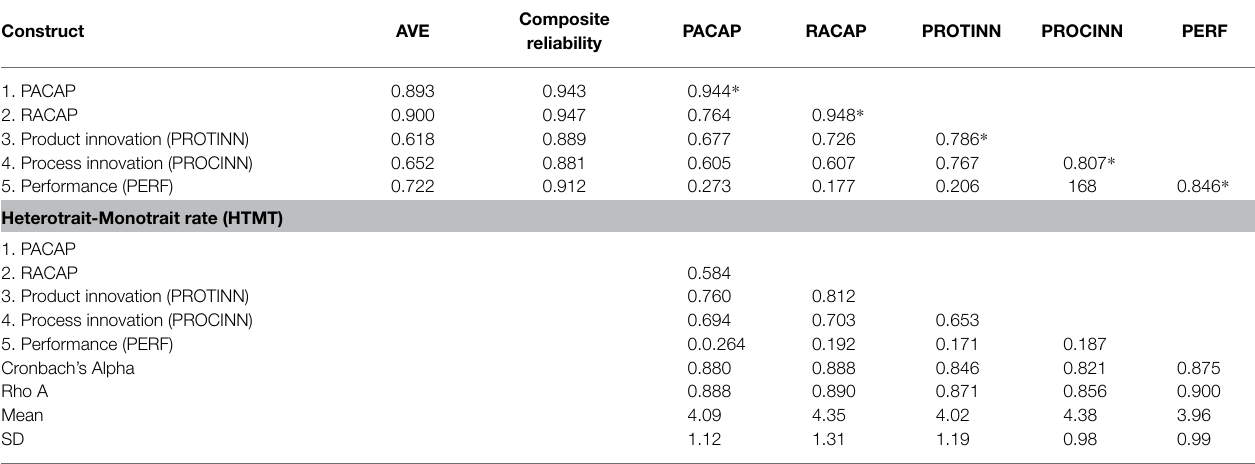
TABLE 4 | Correlation matrix, composite reliability, convergent and discriminant validity, Heterotrait-Monotrait ratio (HTMT), and descriptive statistics. Construct